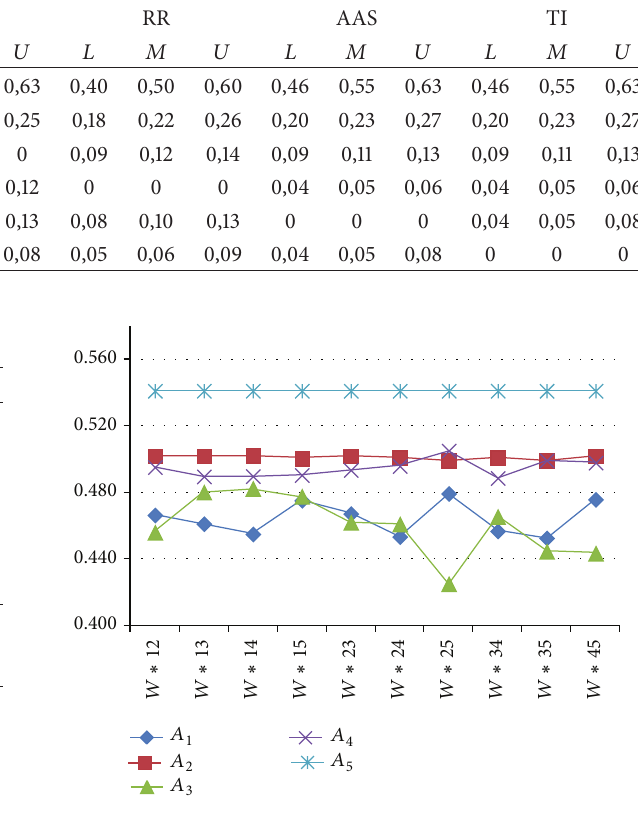
Figure 5: New 𝑊∗ values for the